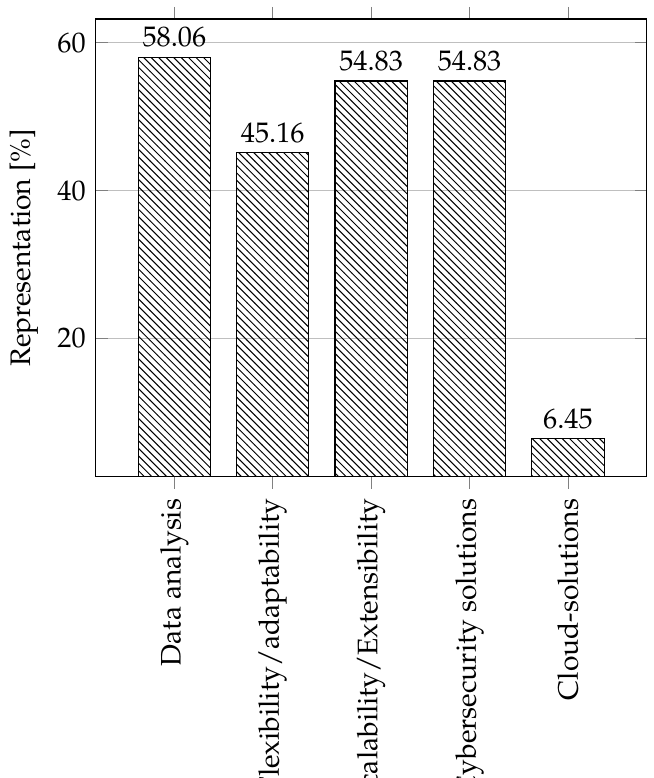
Figure 20. The percentage of selected testbeds’ components.